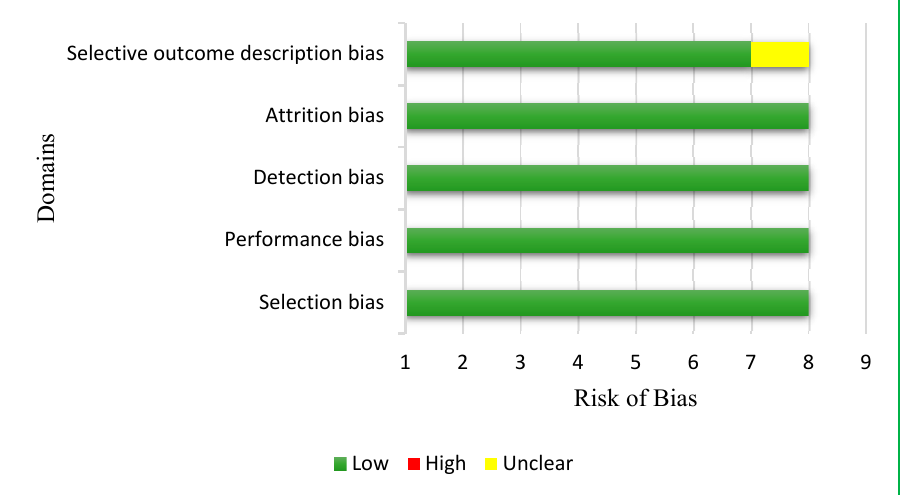
Figure 2. Risk of bias in the analyzed articles.